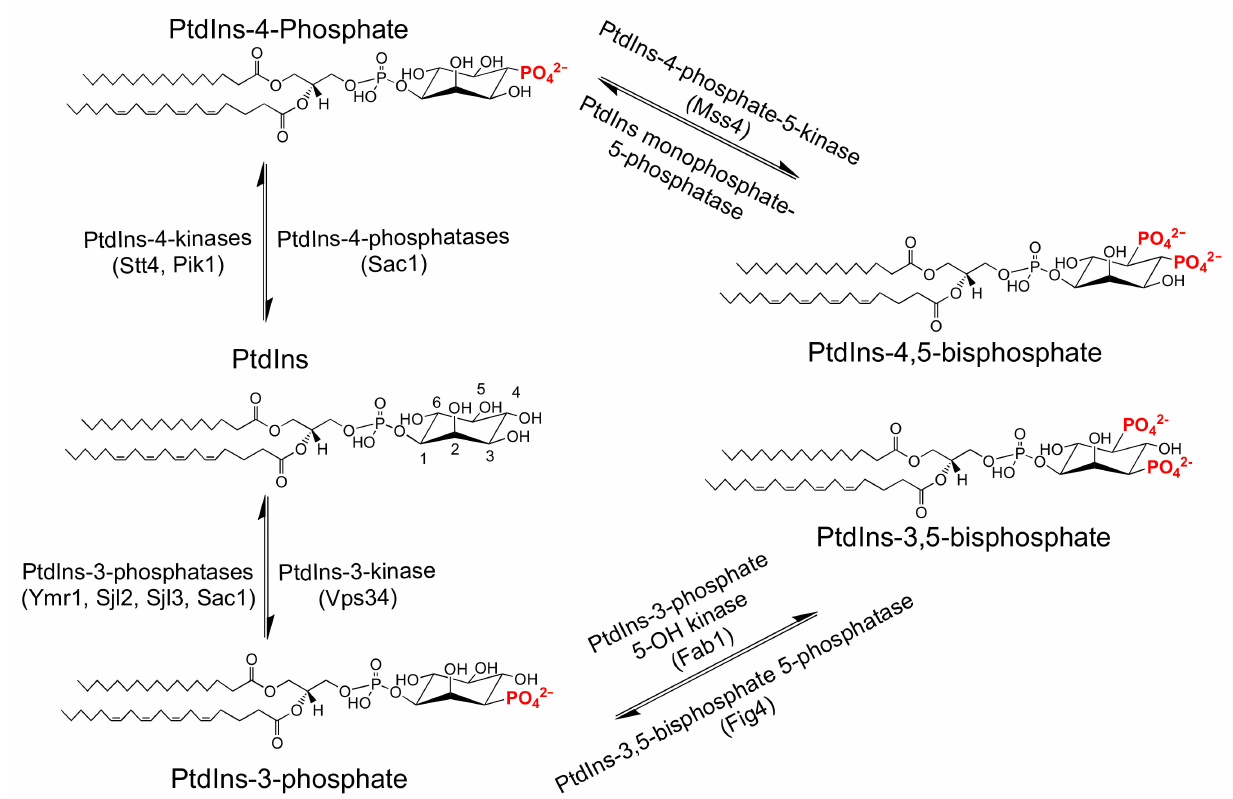
Figure 3. S. cerevisiae phosphoinositide metabolism. Along with phosphatidylinositol, yeast produces five distinct phosphoinositide species. Synthesis of individual phosphoinositide species occur by one or two sequential phosphorylation events at the phosphatidylinositol headgroup. All phosphoinositide species are generated by the action of specific kinases, with the exception of PtdIns(4)P, whose production is catalyzed by one of two distinct and functionally non-redundant PtdIns 4-OH kinases. PITPs boost the formation of PtdIns(4)P by priming the activities of both of these PtdIns 4-OH kinases. Phosphoinositide phosphatases act in opposition to the lipid kinases to degrade phosphoinositides. Some of these enzymes exhibit somewhat relaxed substrate specificities. For example, Sac1, the major PtdIns(4)P phosphatase in yeast, has the capacity to catalyze dephosphorylation of several mono- and bis-phosphoinositide